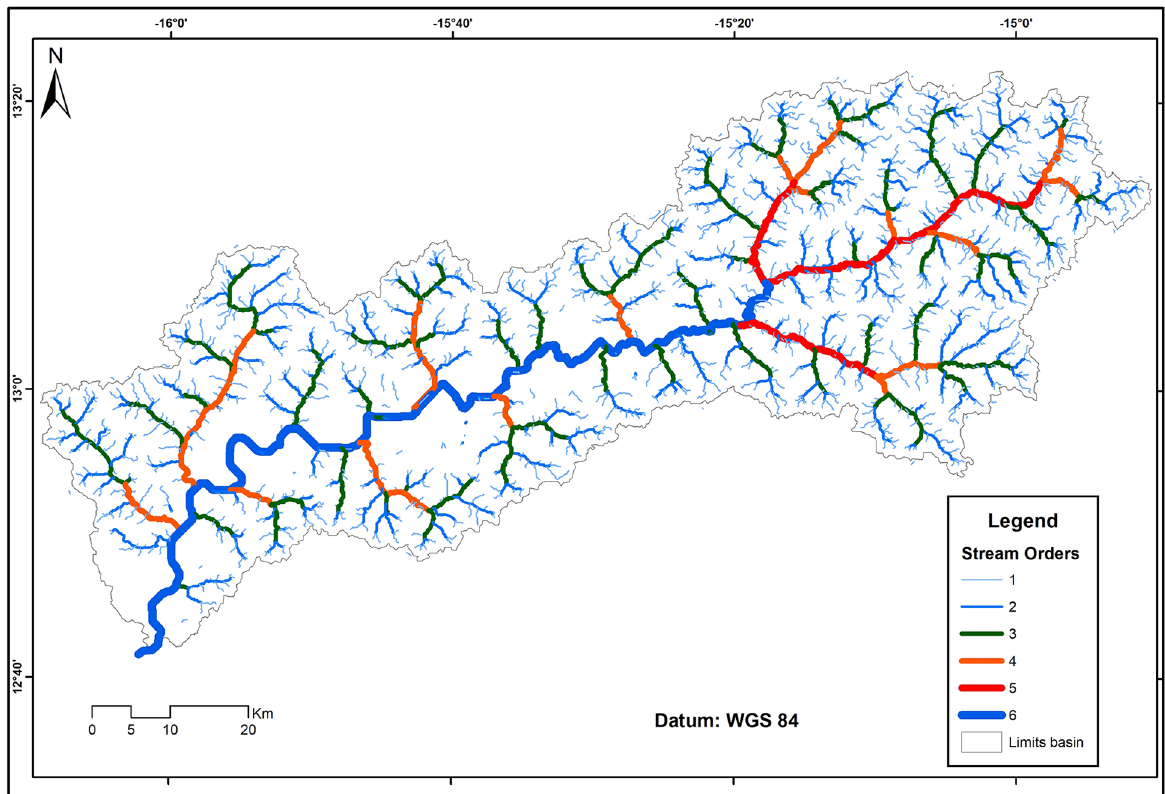
Fig. 3. Order of the rivers in the Soungrougrou